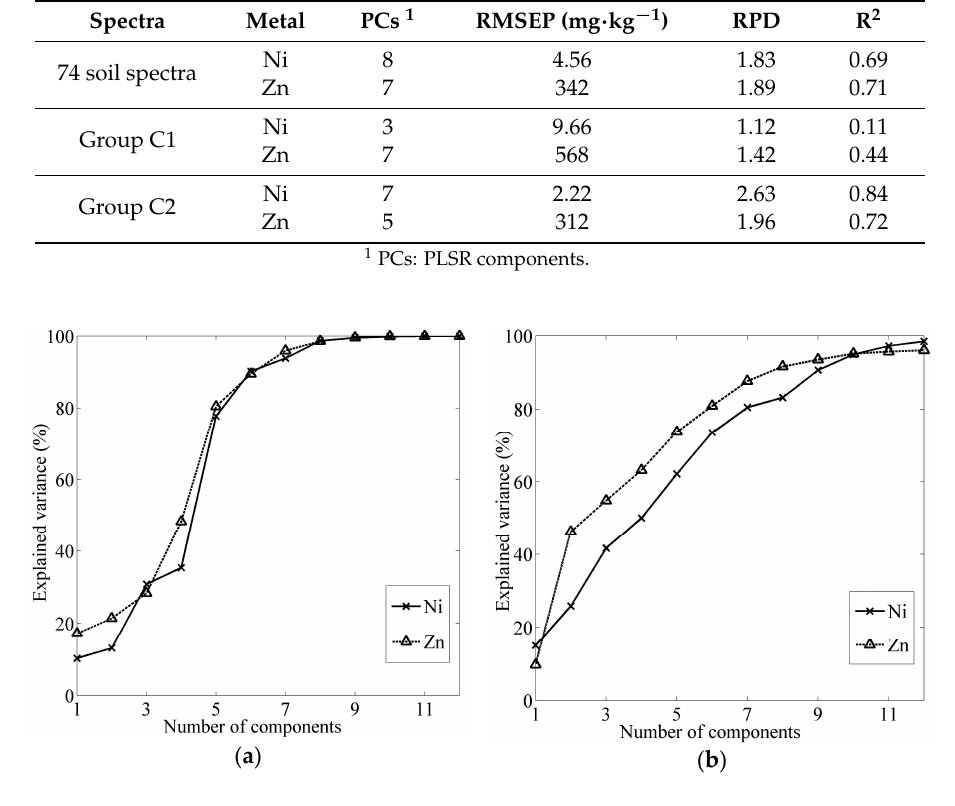
Figure 7. The explained variance of the element variables and variance increment for the respective number of components in the calibration set: ( a ) the explained variance and variance increments for calibration set of Group C1; and ( b ) the explained variance and variance increments for calibration set of Group C2.